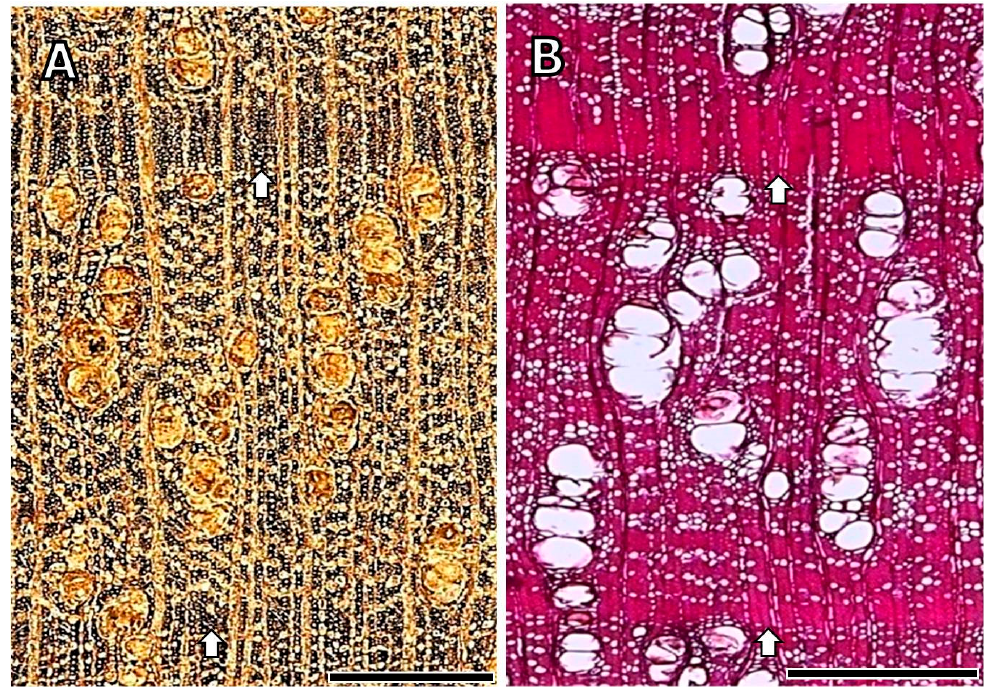
Figure 3. Growth ring structure of D. butyracea ; ( A ) stereomicroscopic image and ( B ) light micrograph. The white arrow indicates the ring boundary. Scale bars = 500 µm.